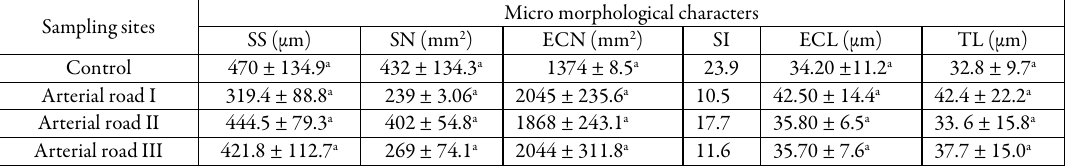
Table 7. Effect of vehicular pollution on micro-morphological variations of Ficus platyphylla leaves at the study sites in Kumasi Metropolis Sampling